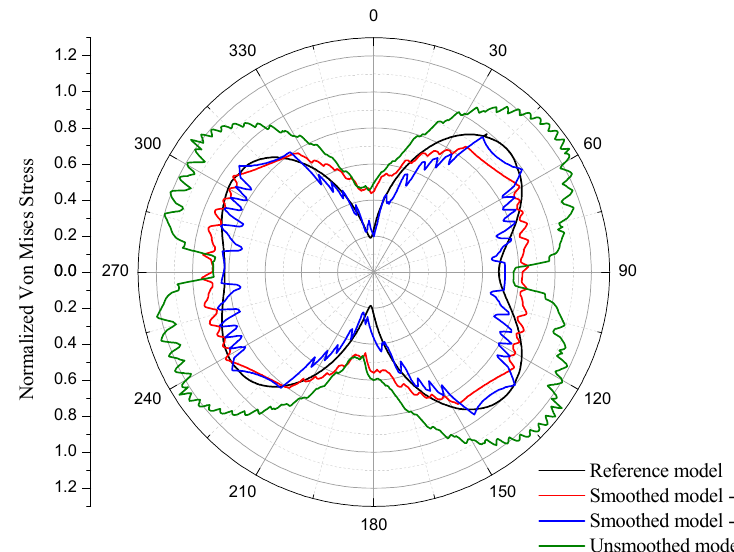
Figure 10. Normalized von Mises at the interfaces of the four models.